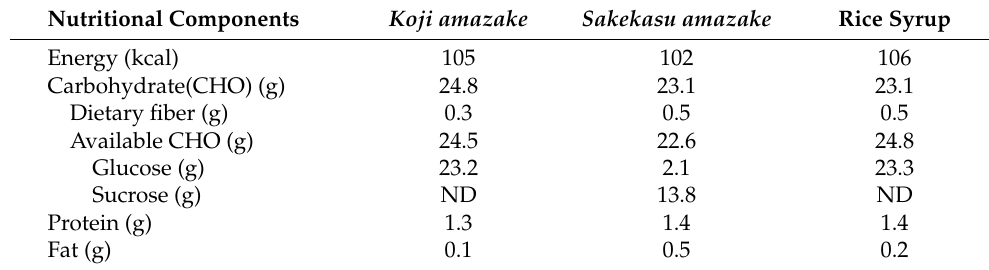
Table 1. Nutritional components of koji amazake , sakekasu amazake , and rice syrup as a placebo (per 100 g). Nutritional Components Koji